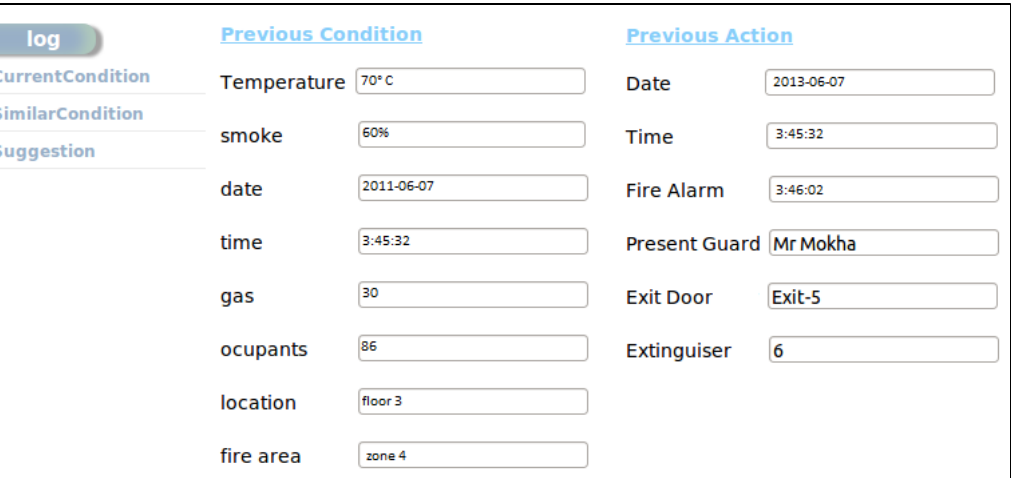
Figure 17. Similar conditions and actions from log